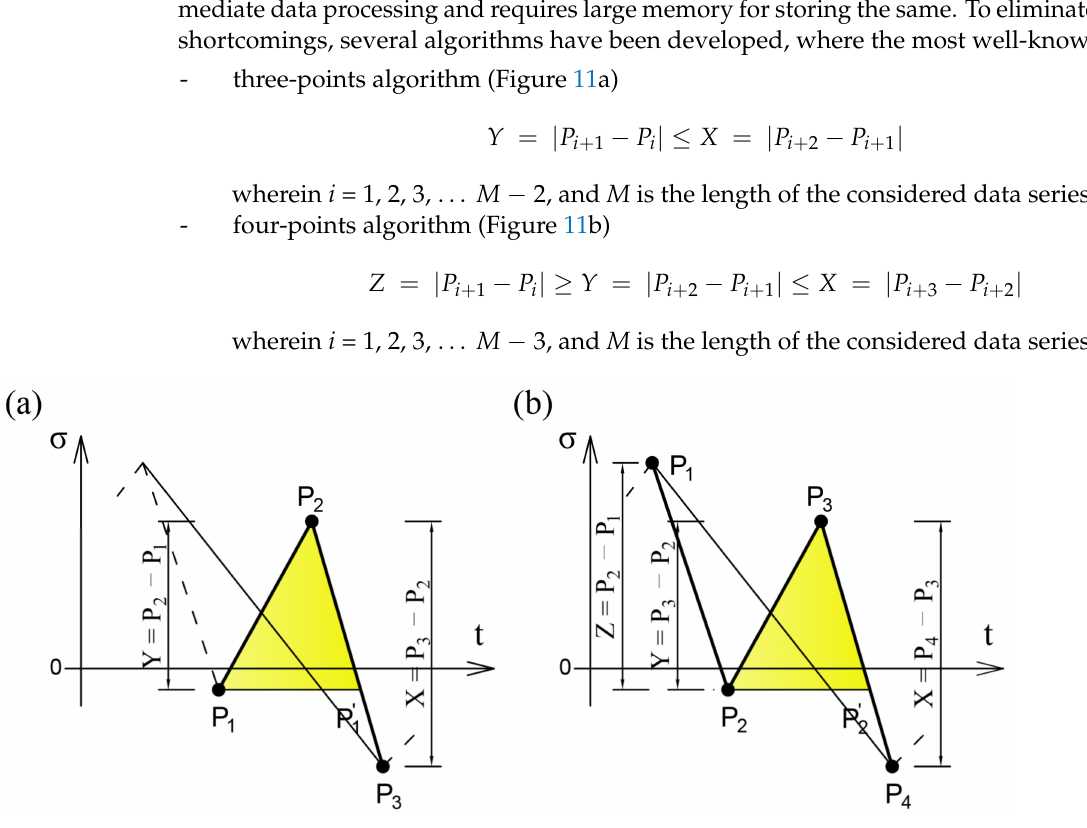
Figure 11. Rainflow cycle counting method: ( a ) three-points algorithm and ( b ) four-points algorithm.